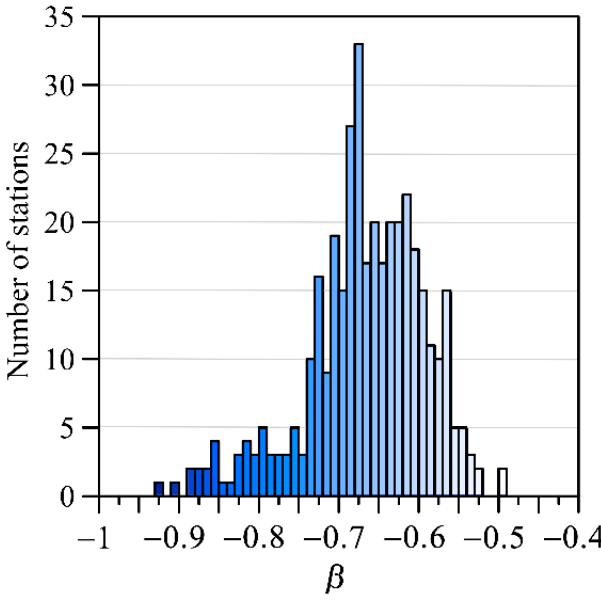
Figure 4. Histogram of the empirical values of the scaling parameter β . A certain spatial pattern can be observed in accordance with different geographical and climatological zones. A percentage of 88.6% of the values of β resulted above − 0.75, whereas the 11.4% lower are mostly located at the eastern part of the region (Figure 5), being lowest (under − 0.85) at its most eastern end. At the other end of the range, there are two mountainous zones where the parameter has values higher than − 0.60: in the extremes east and west of Sierra Morena in the north, and in Sierra de Grazalema in the south, a mountain massif which forces the humid air masses from the Atlantic Ocean to lift, leading to intense amounts of precipitation. The values of β are in great concordance with pluviosity, as can be seen in Figure 6a where the mean annual rainfall (Total precipitation: PRCPTOT) is represented for every station. However, there is also a clear dependence with rainfall irregularity. The ratio between every annual maximum daily and its corresponding annual PRCPTOT is related to irregularity; high values mean that a single maximum amount contributes greatly to the total annual amount, while low values correspond to rainy places where the rainfall regime is more regular, and the daily maximum does not contribute as much to total annual rainfall, so there are often other secondary maxima with high amounts. Figure 6b represents dependence between β and the averaged value of this ratio in every station. Notice how in Figure 6b the maximum value of the scaling parameter, − 0.92, corresponds to a station (Pulp í ) where this ratio is 0.2, i.e., the maximum daily amount contributes, on average, more than 20% to the annual rainfall amount in this